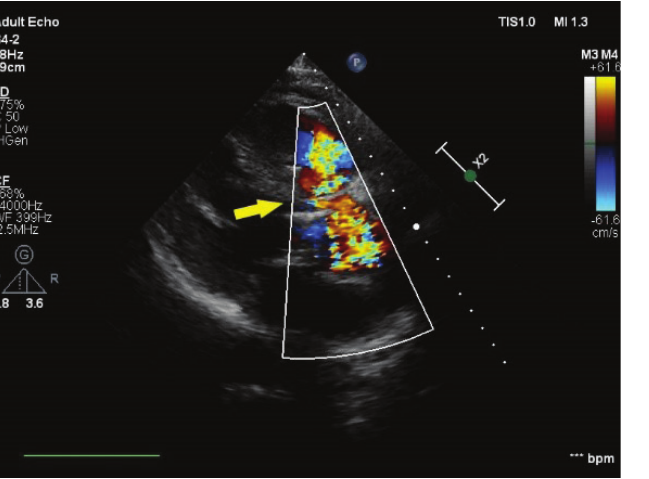
Figure 2 - Two-dimensional transthoracic echocardiogram parasternal long axis (PLAX) view with color flow doppler of fistula tract (arrow)